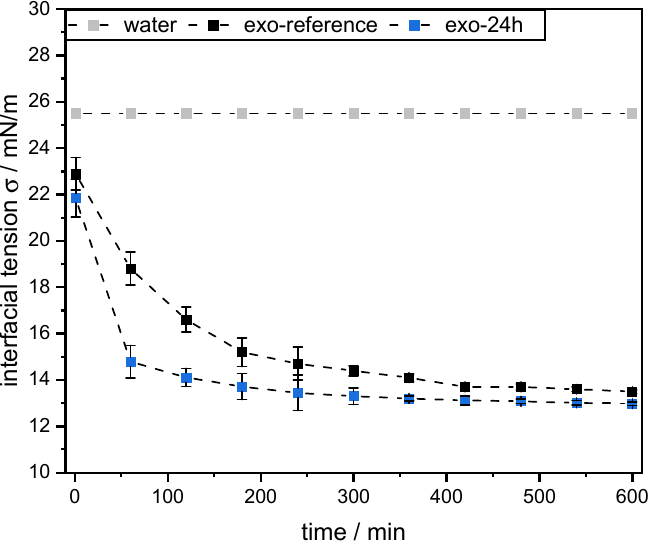
Figure 10. The mct oil–water interfacial tension, using 0.1 wt% pectin solutions with and without enzymatic modification (24 h enzymatic treatment using exo -polygalacturonanase), measured over the time at 25 °C. As a reference, the interfacial tension w as measured without the addition of pectin.